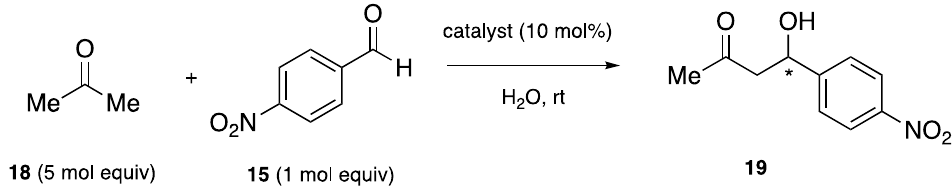
Table 2. Catalysis of the aqueous aldol reaction of acetone with 4-nitrobenzaldehyde a . Entry Catalyst